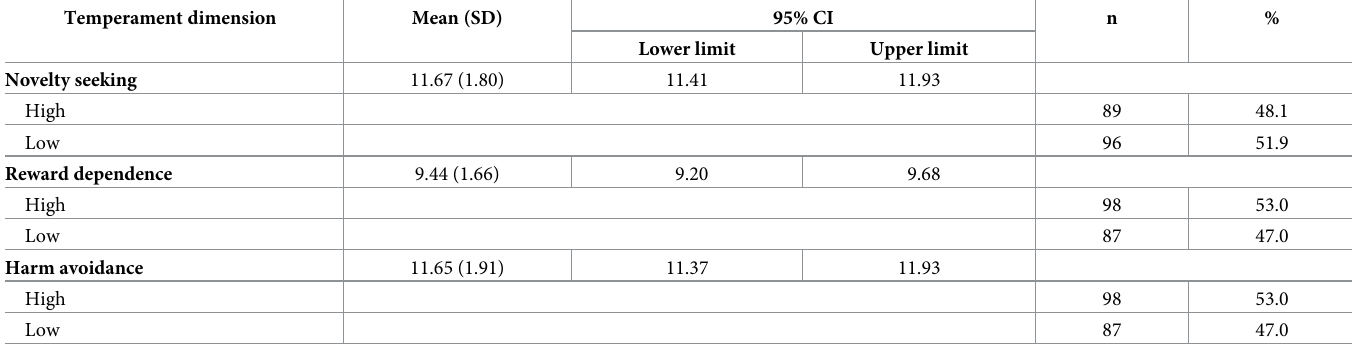
Table 4. The temperament profile of the study